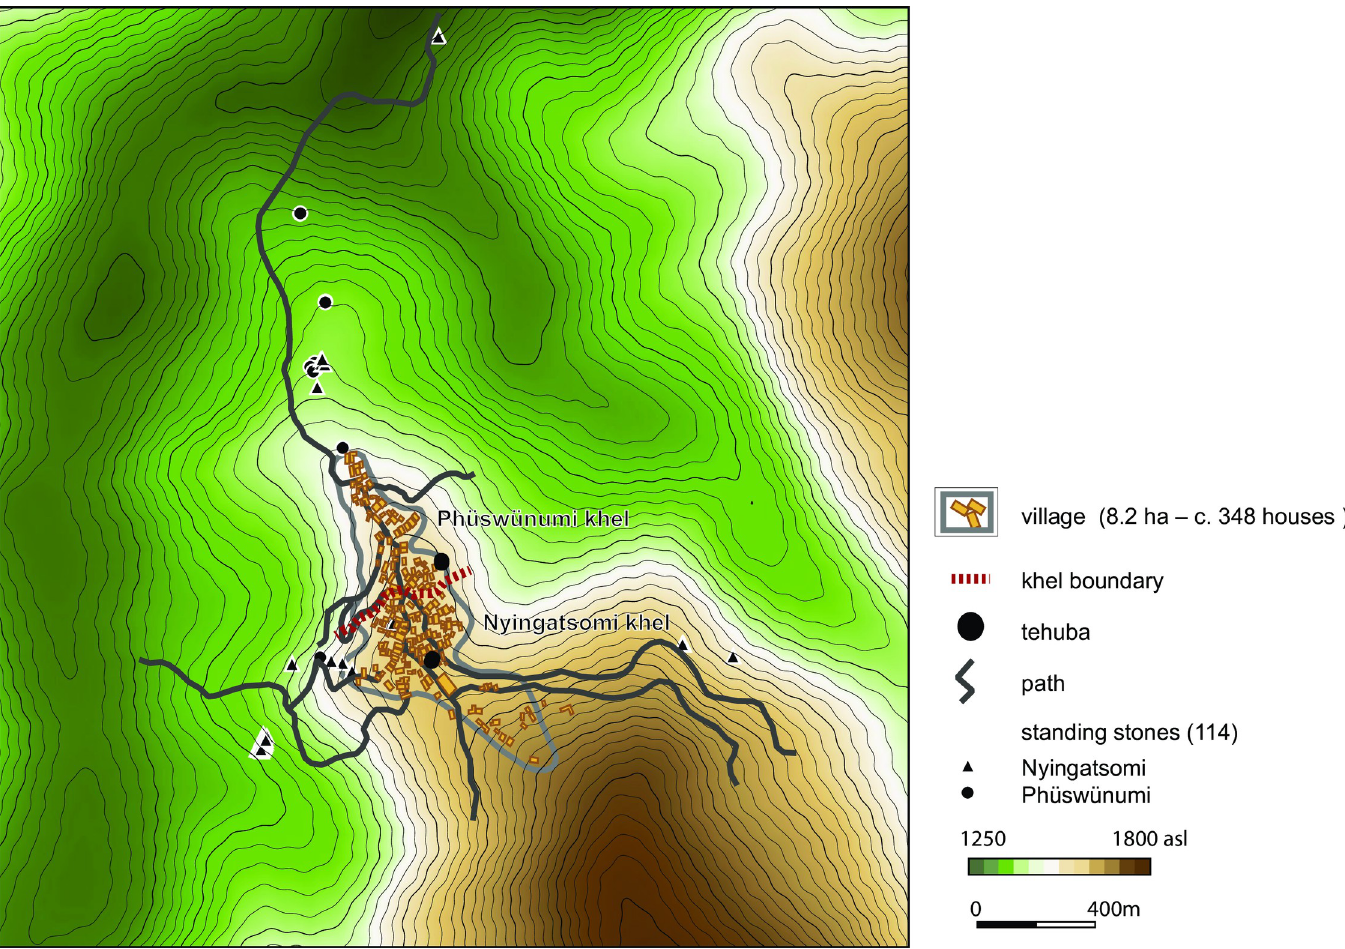
Fig 7. The association of the megalithic monuments with the two khels (Nyingatsomi and Phu¨swu¨numi) present in the Chakhesang village of Ru¨nguzu. The